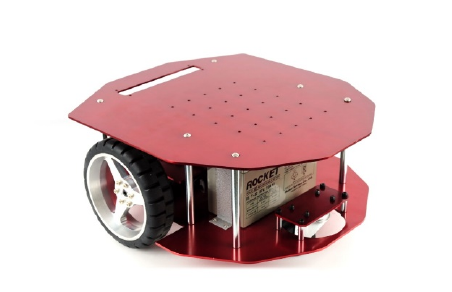
Figure 4. Stella B3.